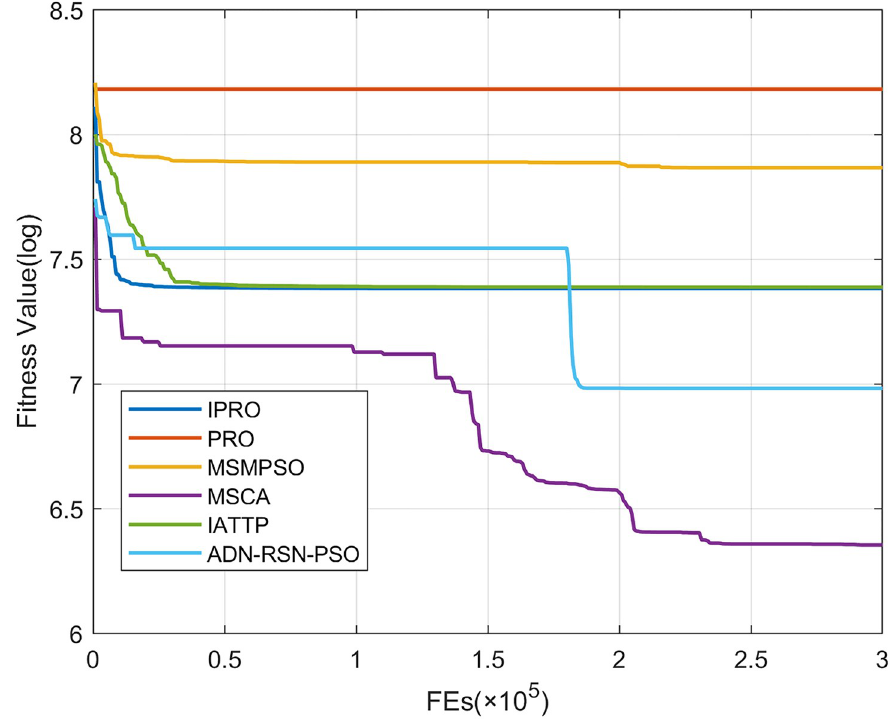
Fig 27. Convergence curves on F27.